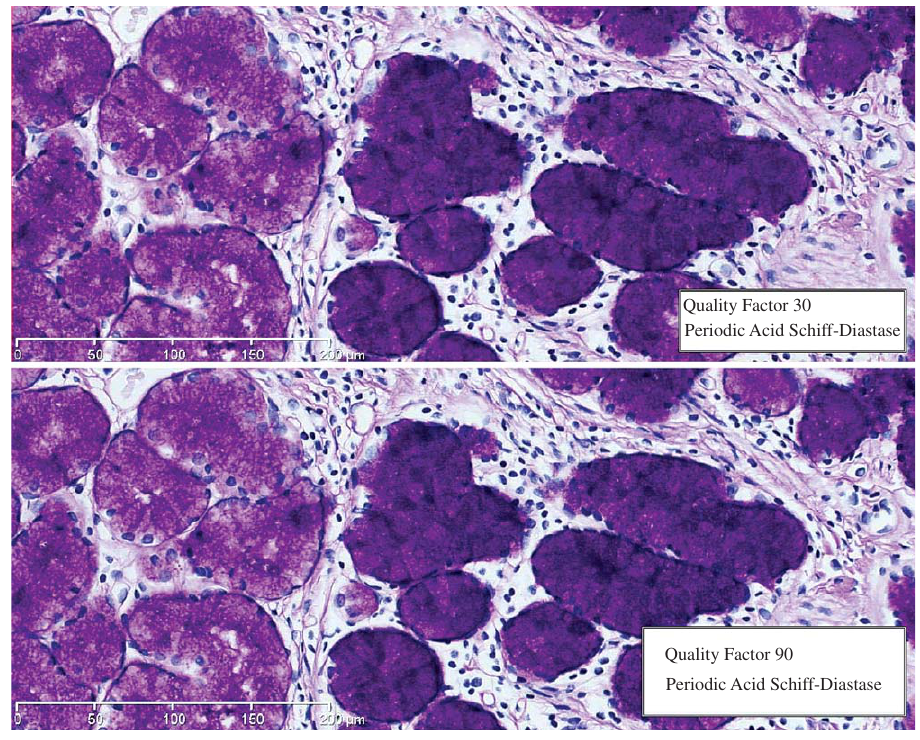
Fig. 2. Periodic Acid Schiff-Diastase slide scanned at 30 and 90 has not lost visual